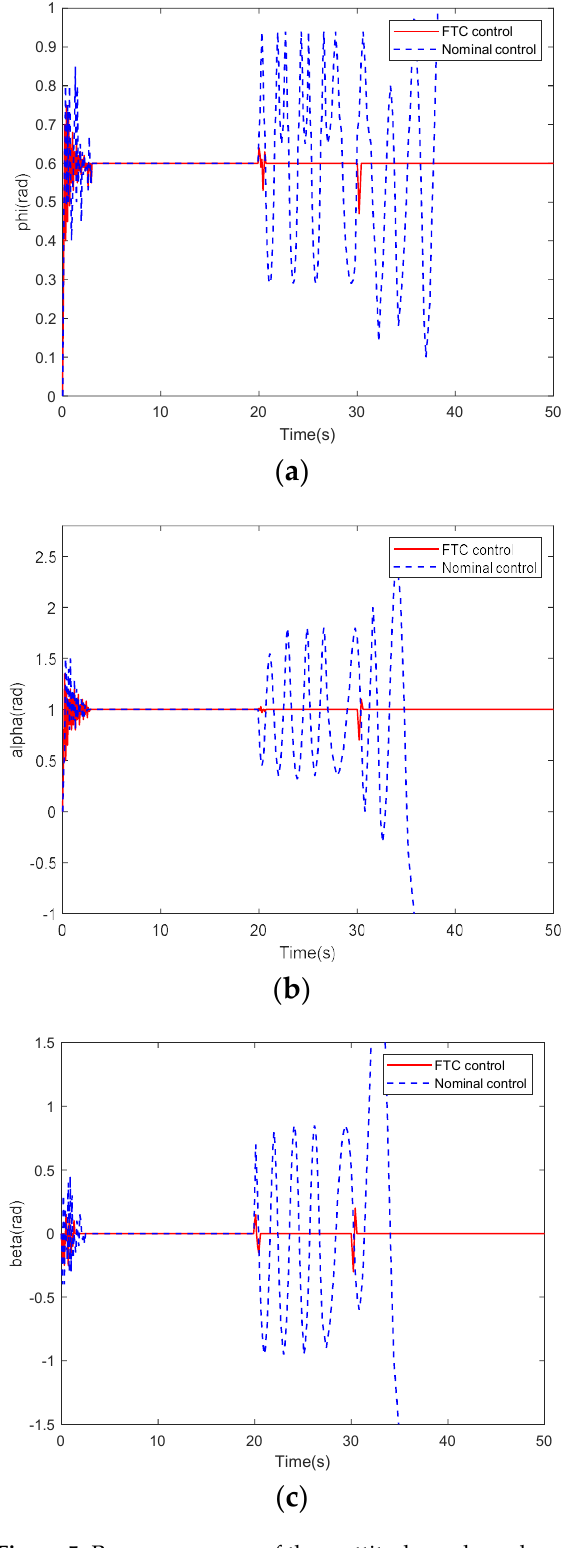
Figure 5. Response curves of three attitude angle under sensor faults: ( a ) ϕ ; ( b ) α ; and ( c ) β .